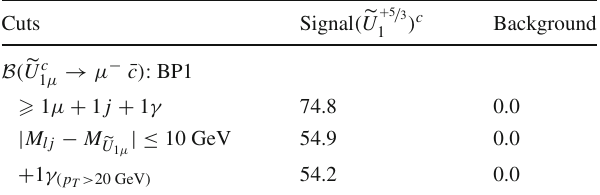
Table 9 Number of events after the cumulative cuts for the vector singlet leptoquark (cid:8) U c HERA Cuts Signal ( (cid:8) U + 5